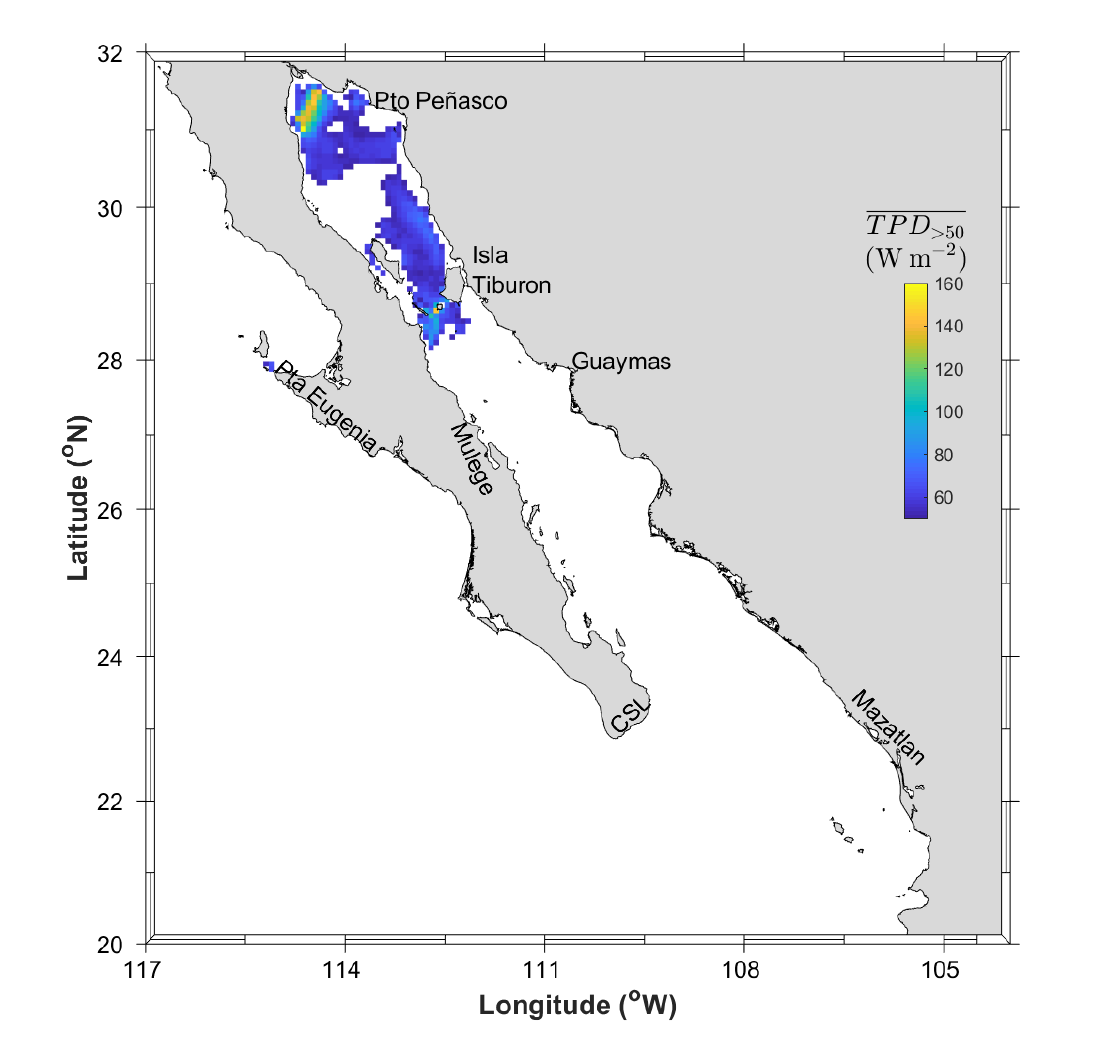
Figure 5. Map of TPD > 50 , corresponding to the mean of TPD when TPD > 50 W m − 2 . Table 3. Locations with largest six maximal speeds, U max , over the simulation